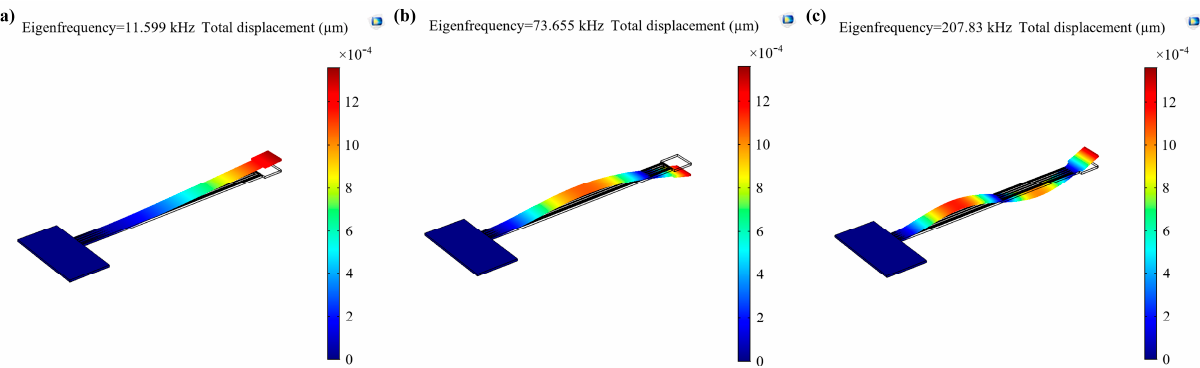
Figure 7. The eigenfrequency of the 1st, 2nd, and 3rd-order resonance mode with COMSOL Multiphysics simulation. ( a ) The first-order resonance frequency, 11.599 kHz; ( b ) the second-order resonance frequency, 73.655 kHz; ( c ) the third-order resonance frequency, 207.830